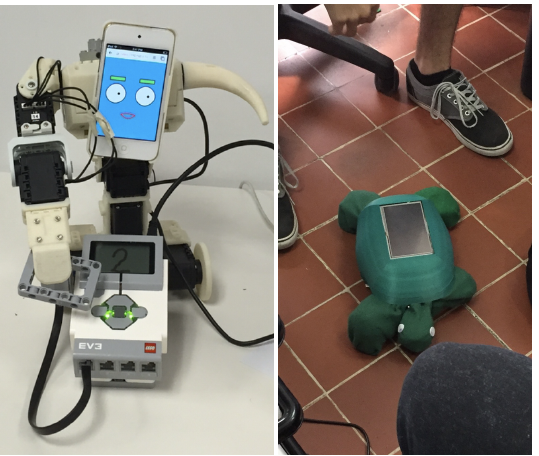
Figure 2: Different robots built in-house for cognitive therapies, including TBI and